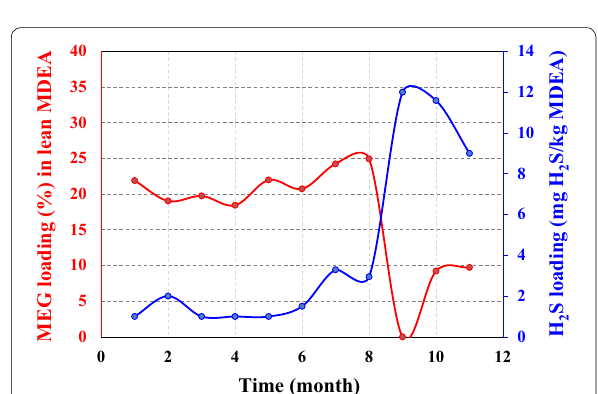
Fig. 5 MEG concentration versus acid gas loading in lean amine solution